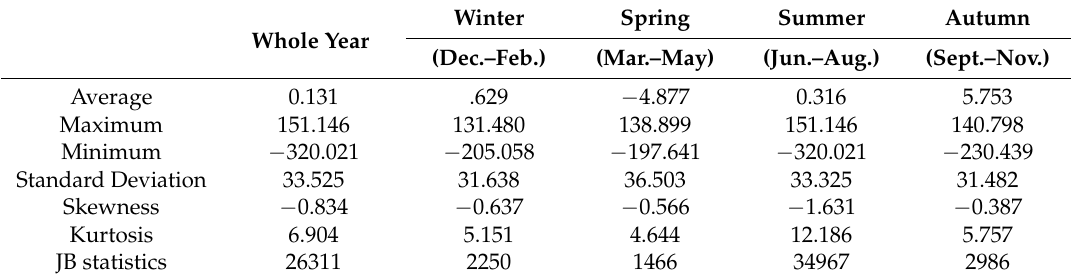
Table 1. Descriptive statistics for imbalance data over 2015 and calendar